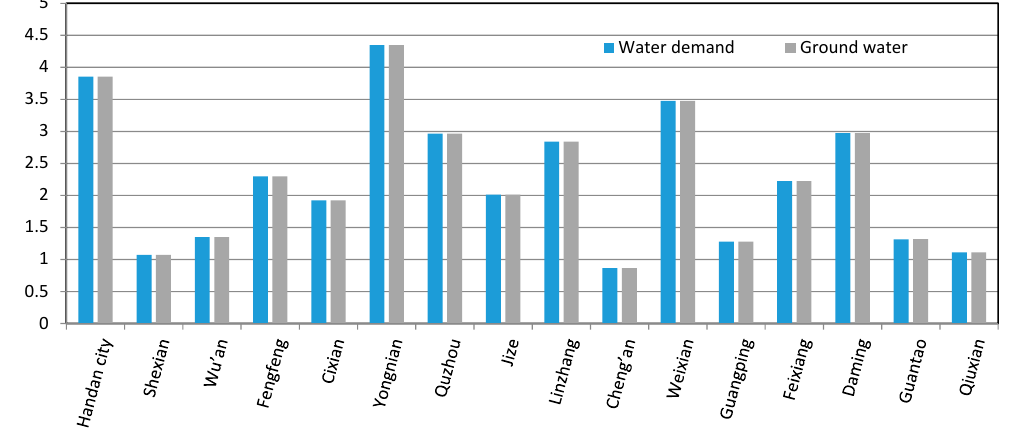
Figure 5. Rural domestic water allocation in each sub-region in Handan (10 6 m 3 ).